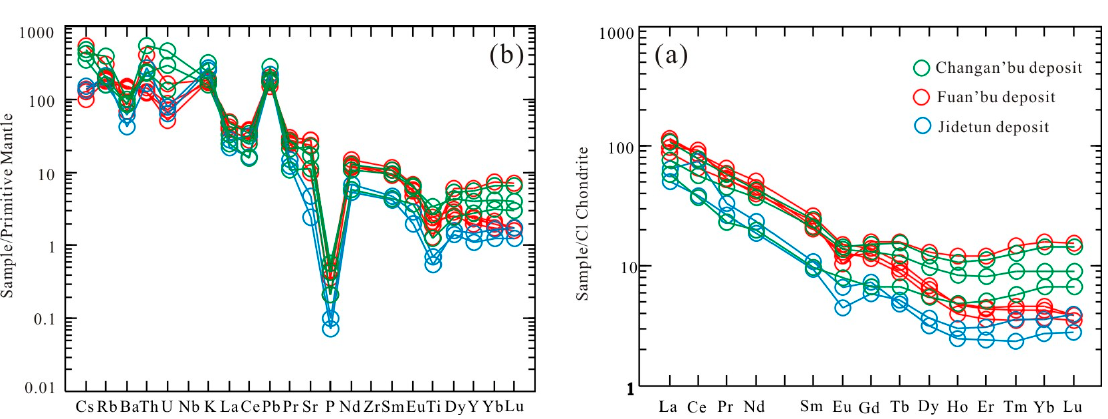
Figure 7. Primitive-mantle-normalized multi-element and chondrite-normalized rare earth element (REE) patterns for ore-hosting rocks from the Chang’anbu, Fu’anbu, and Jidetun deposits. ( a ) primitive-mantle-normalized multi-element patterns for ore-hosting rocks; ( b ) chondrite-normalized rare earth element (REE) patterns for ore-hosting rocks.